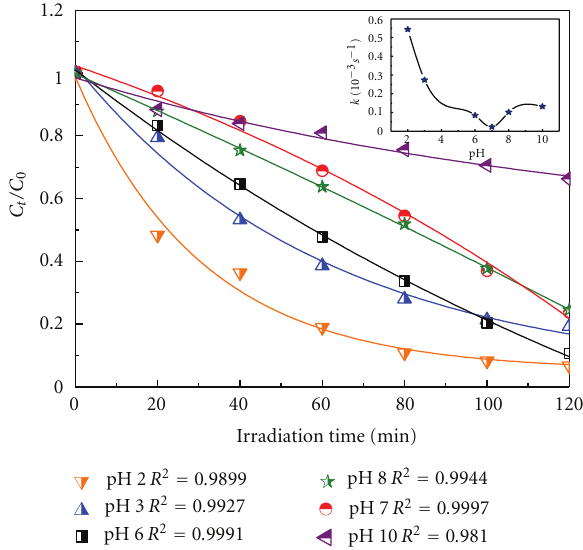
Figure 4: E ff ect of pH on the degradation of naphthalene. Inset graph: rate constant ( k ) versus pH.